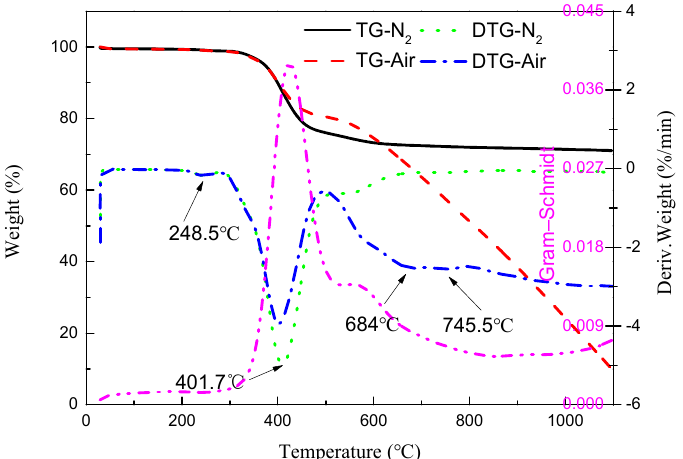
Figure 2. TG and DTG curves for the carbon/epoxy composite material carried out under inert and air atmosphere at 20 °C/min.